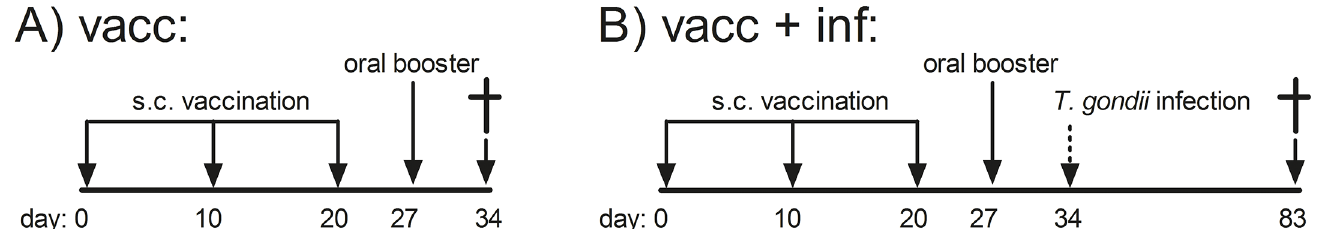
Fig 1. Experimental setup. (A) In the first experimental setup mice were subcutaneously (s.c.) vaccinated three times with SMG or TLA adjuvanted with GERBU in 10 day intervals. On day 27, an oral TLA booster adjuvanted with cholera toxin (CT) was administered in 3% NaHCO 3 buffer and the experiment was terminated on day 34. Sham-vaccinated mice (sham) were sham-vaccinated with GERBU-PBS and sham-boosted with CT in 3% NaHCO 3 . (B) In the subsequent setup mice were systemically vaccinated and orally boosted as described in (A) before infection with 500 T . gondii oocysts in 3% NaHCO 3 buffer on day 34 via gavage (SMG + inf; TLA + inf). Sham-vaccinated/infected mice (sham + inf) were sham-vaccinated with GERBU-PBS and sham-boosted with CT in 3%